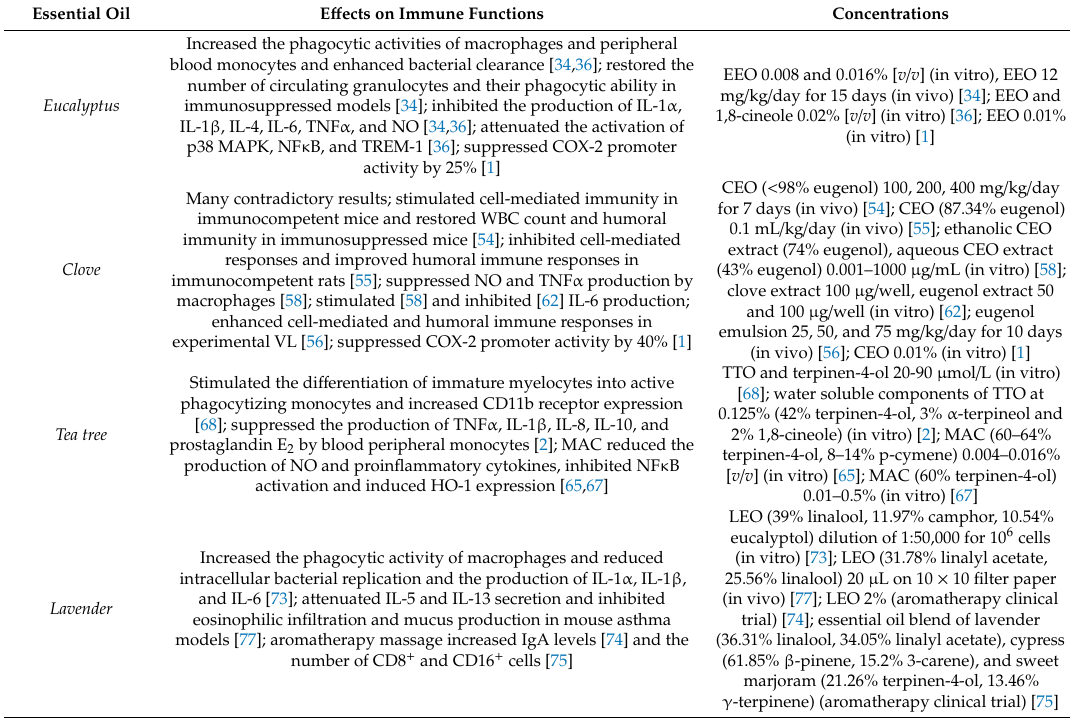
Table 2. Overview of the immunomodulatory e ff ects and concentrations of selected essential oils. Essential Oil E ff ects on Immune Functions